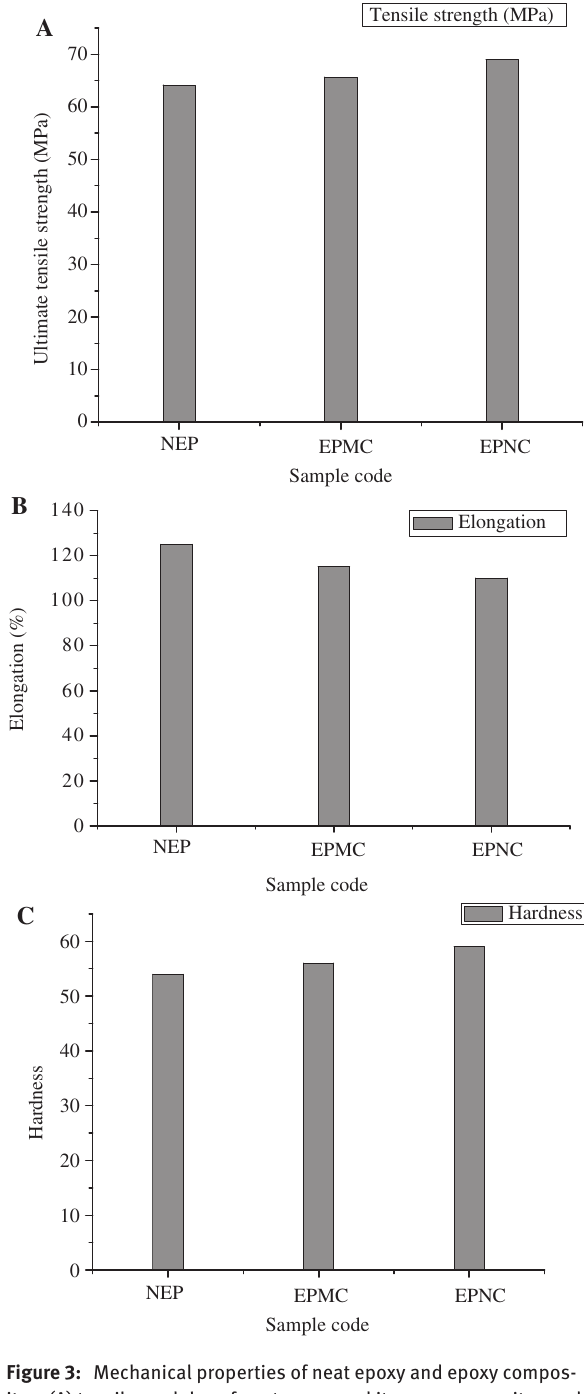
Figure 3: Mechanical properties of neat epoxy and epoxy compos- ites: (A) tensile modules of neat epoxy and its nanocomposites and microcomposites; (B) percentage of elongation of neat epoxy and its and its nanocomposites and